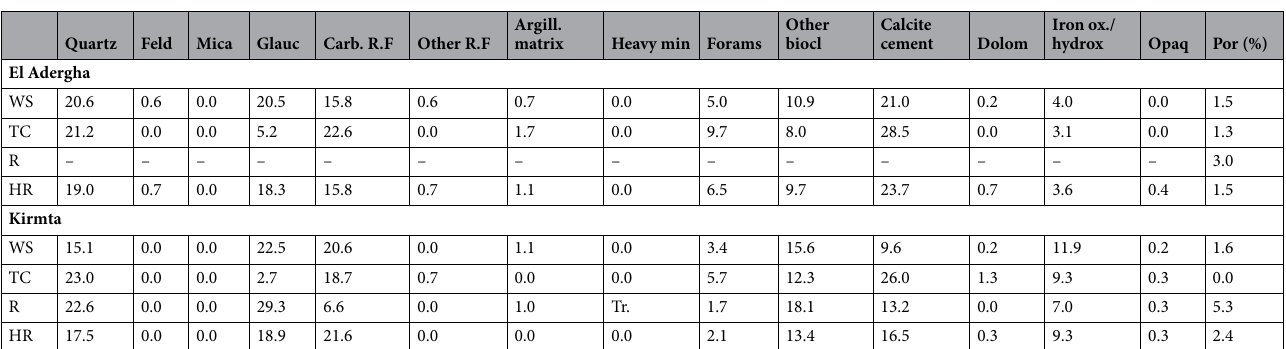
Table 1. Mean values of composition and porosity from analyzed samples considering the whole sample (WS), tube core (TC), rim (R) and host rock (HR). Tr. Traces, Feld. Feldspar, Glauc. Glauconite, Carb.